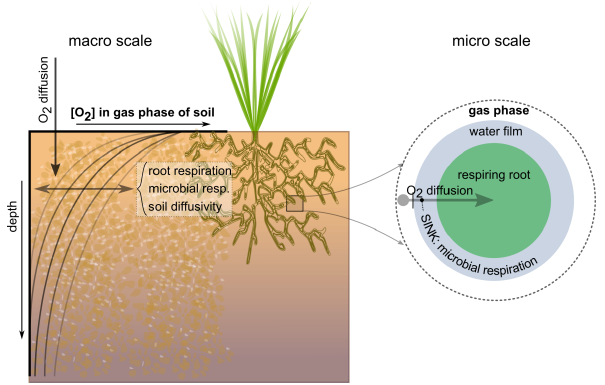
Figure 3. Schematisation of the oxygen module used to simulate daily respiration reduction. The model combines interacting physi- ological processes (i.e. root respiration and microbial respiration) and physical processes (i.e. macro-scale and micro-scale oxygen diffusion). Details of equations involved are given in Bartholomeus et al.